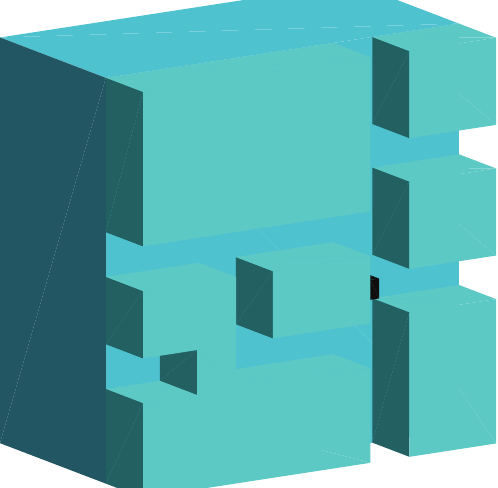
Figure 3: A Geant4 representation of a part of UNIREA mine with the low background radiation laboratory of IFIN-HH shown with a black box (cid:3) color online (cid:4) .